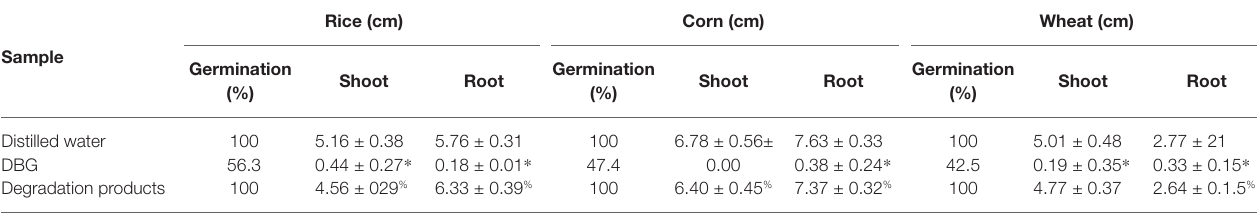
Germination Shoot Root (%)